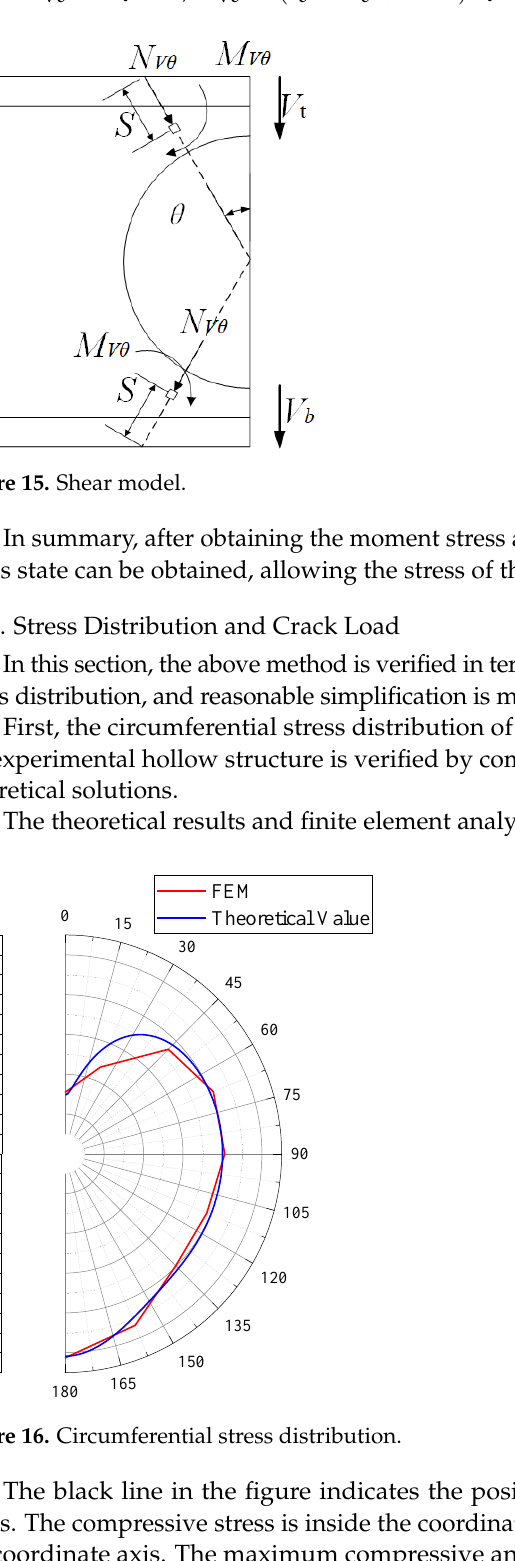
Figure 15. Shear model.